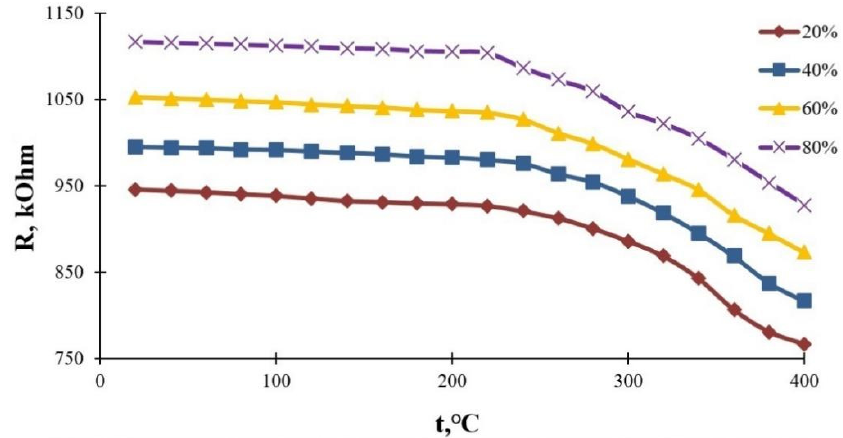
Figure 3. Temperature dependence of the specific surface resistance of thin films obtained on a GaAs surface under the influence of various compositions Y 2 O 3 + Sb 2 O 3 in air.